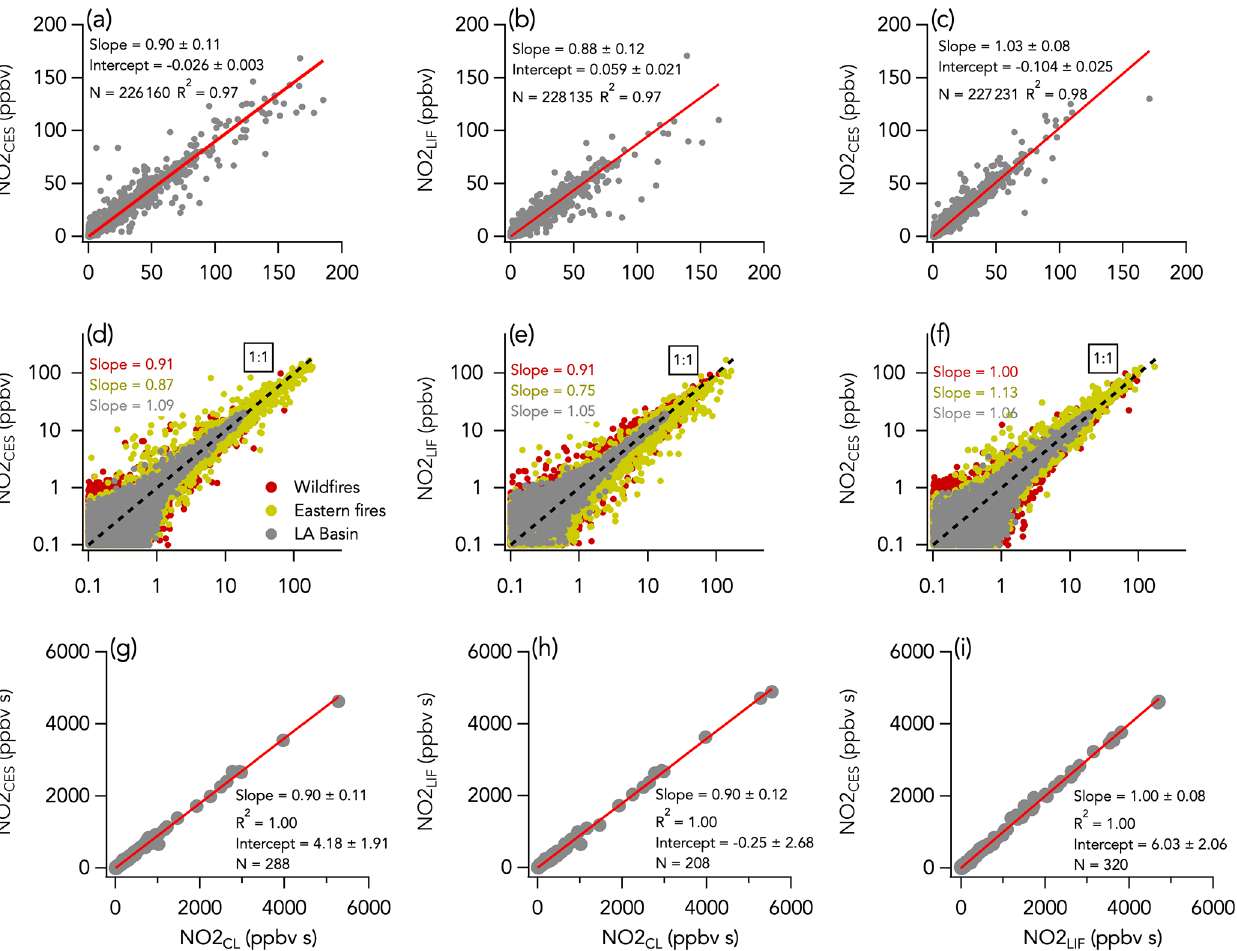
Figure 7. NO 2 measurements by LIF, CES, and CL with (a–c) all 1s data on a linear scale, (d–f) all 1s data on a log scale, and (g–i) integrals of 208–320 crosswind smoke plume transects. N is the number of independent 1s observations or smoke plume transects that are compared. In panels (d) – (f) , the three sampling periods are shown in different colors, with the wildfires sampling period in red, the eastern fires sampling period in mustard, and the Los Angeles (LA) Basin flights in grey. The red lines indicate the fit of the data. The dotted black lines are the 1:1